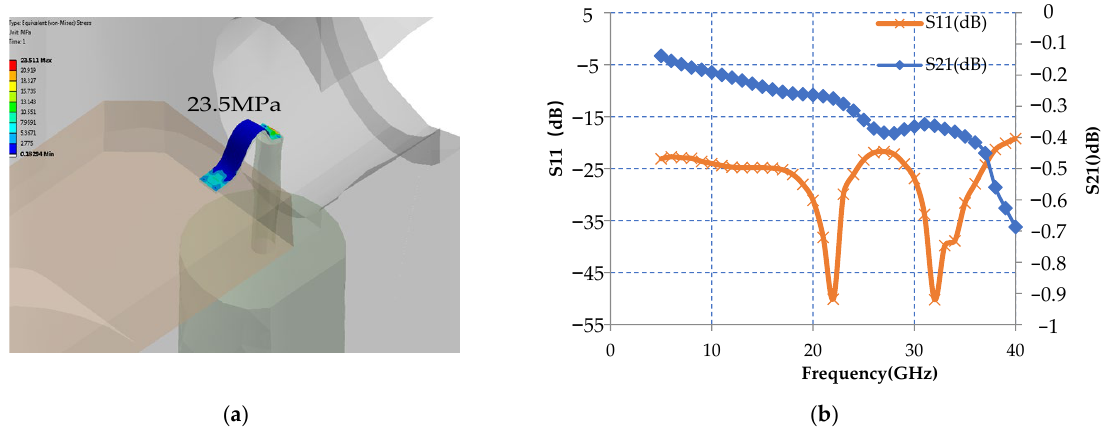
Figure 19. Stress and electromagnetic simulation of the vertical interconnection. ( a ) Stress simulation results; ( b ) Electromagnetic simulation results. The tolerance analysis of its key dimensions is shown in Figures 20 and 21. The arch height of the ribbon and the distance of the gap have little impact on the final reflection loss, which can provide sufficient processing deviation margin for actual assembly.